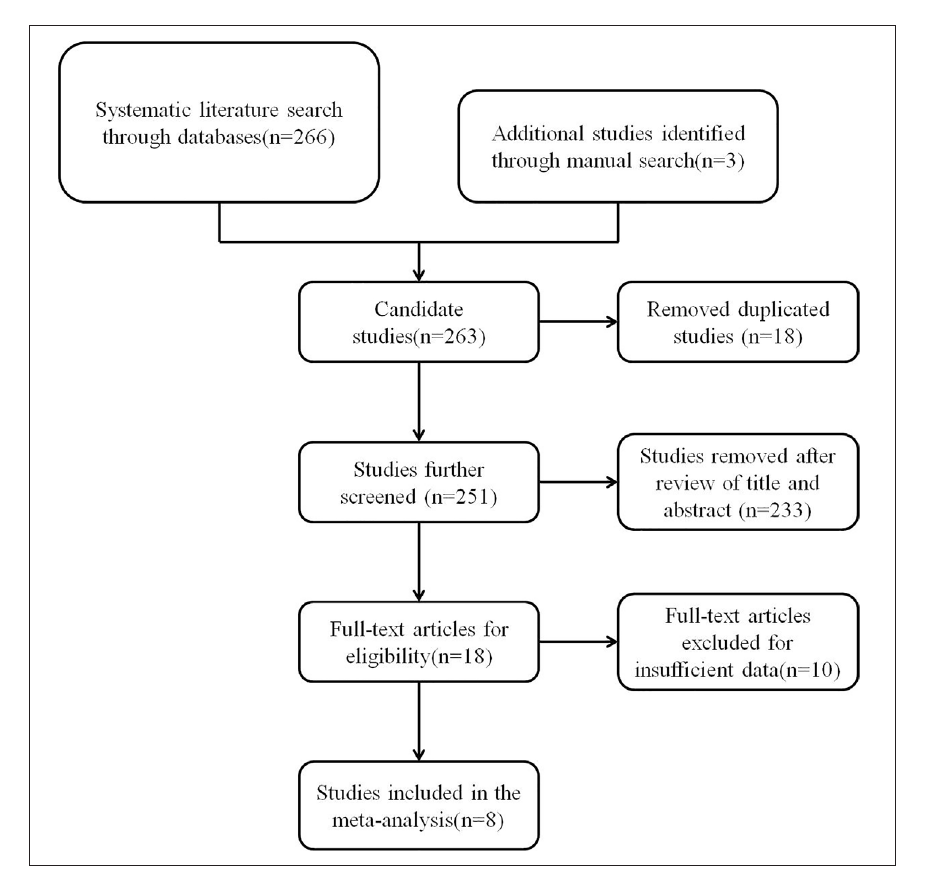
Fig. 1. Flow chart of literature search.